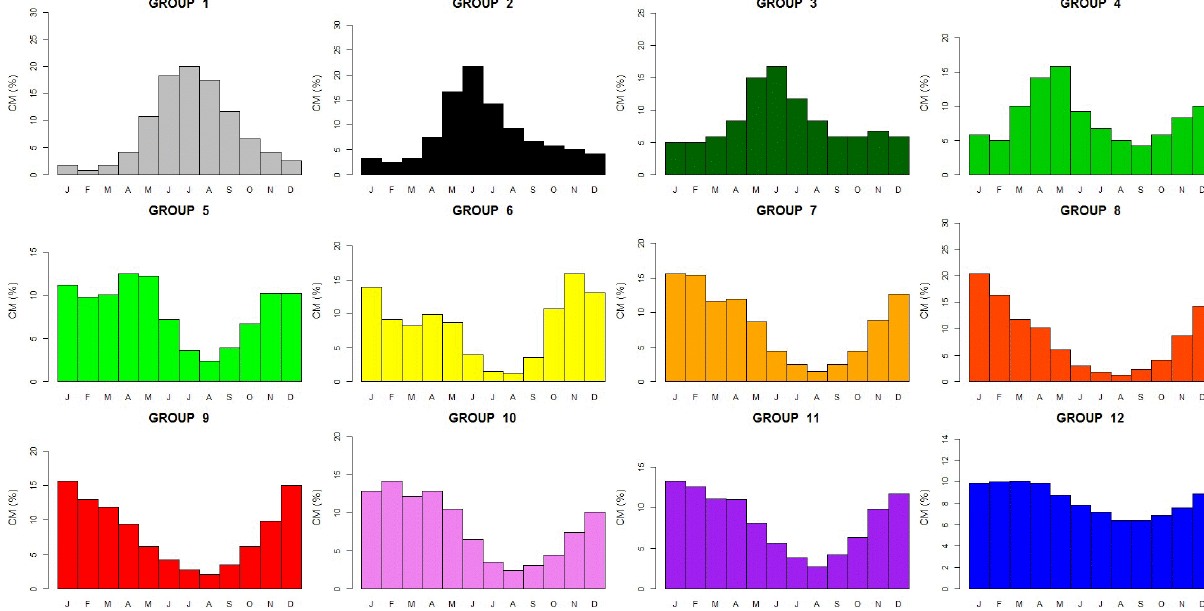
Figure A1. Reference dimensionless hydrographs representative of the classification of river flow regime for France (after Sauquet et al., 2008). The y axis (CM) represents the percent of each month contributing to total annual runoff, equal to monthly runoff (mm) divided by the mean annual runoff